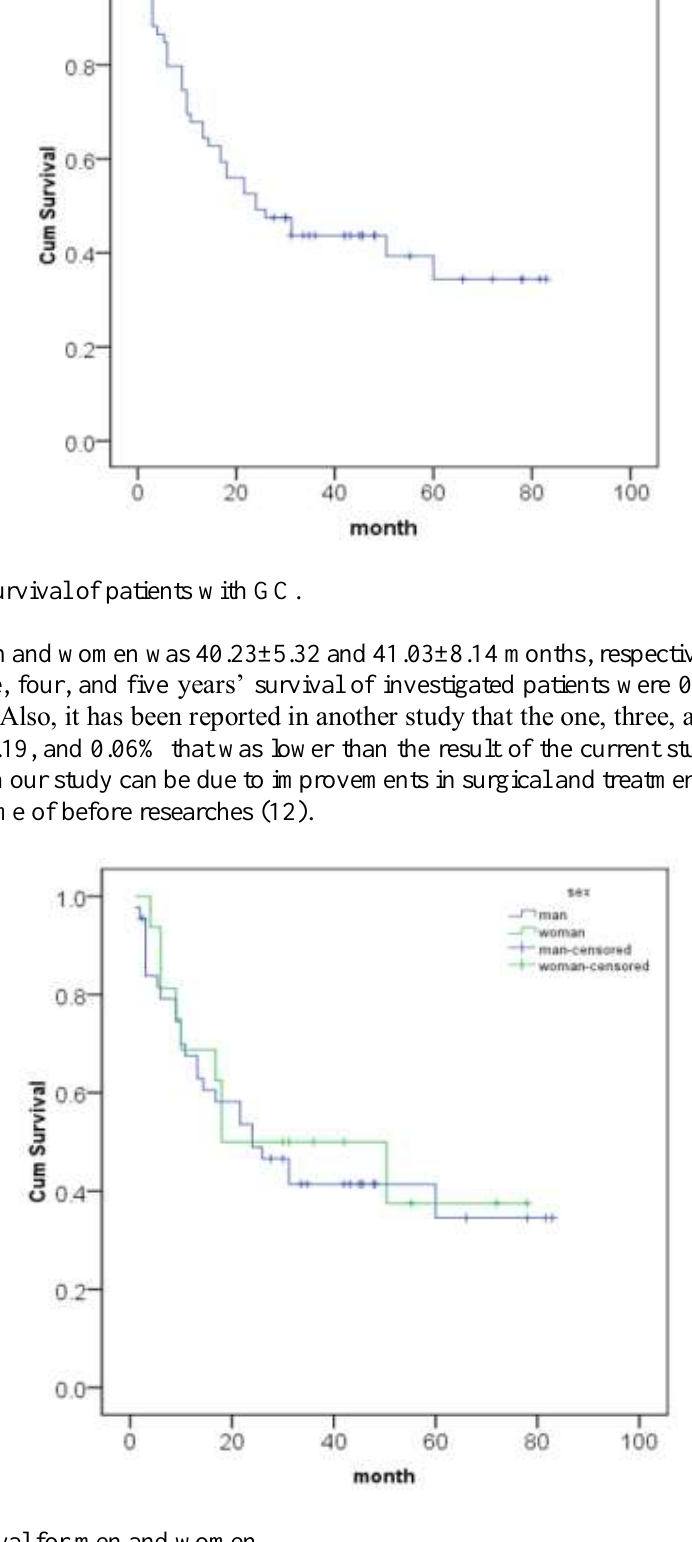
Figure 3: Average survival for men and